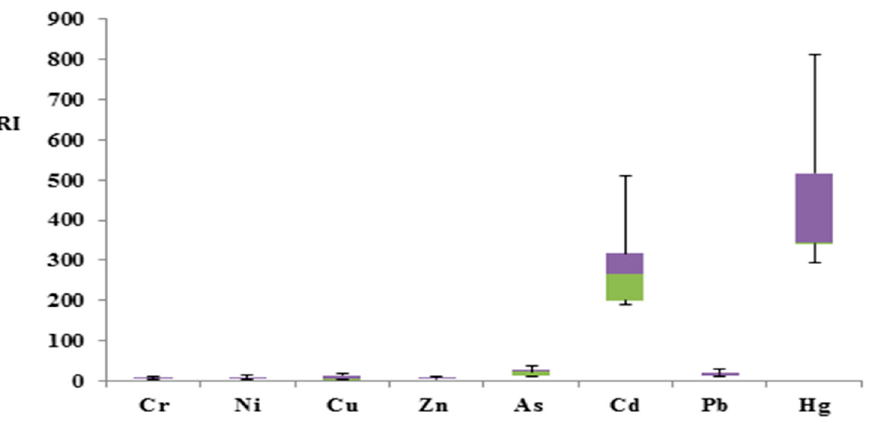
Figure 5. Boxplot of RI (Green color= Quartile group 2, 25%), (Purple color= Quartile group 3, 25%)